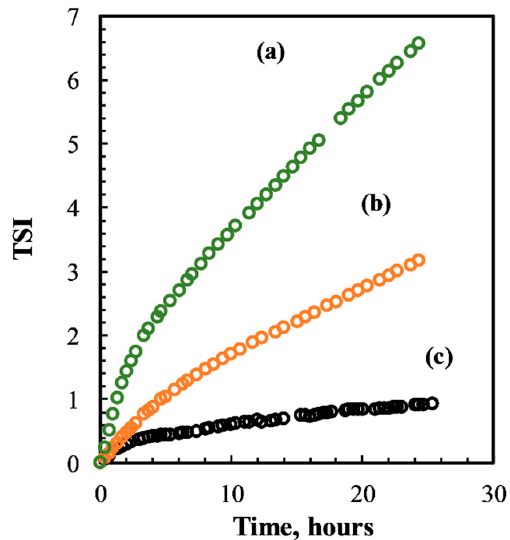
Figure 2. Turbiscan stability index (TSI) obtained for the emulsion samples prepared with 0.1% ( a ); 1% ( b ) and 2% ( c ) WPI ( w/w ) at a pressure of 100 MPa and three microfluidizer cycles.